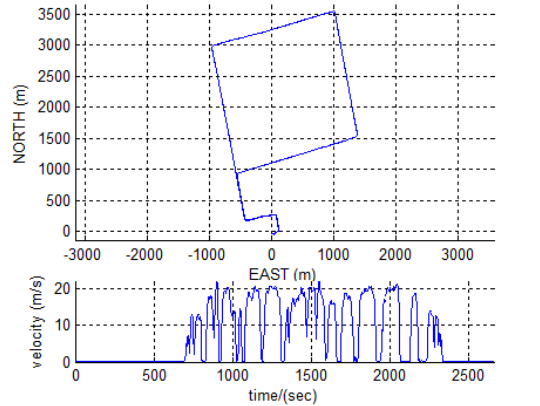
Figure 7. IMU position and velocity